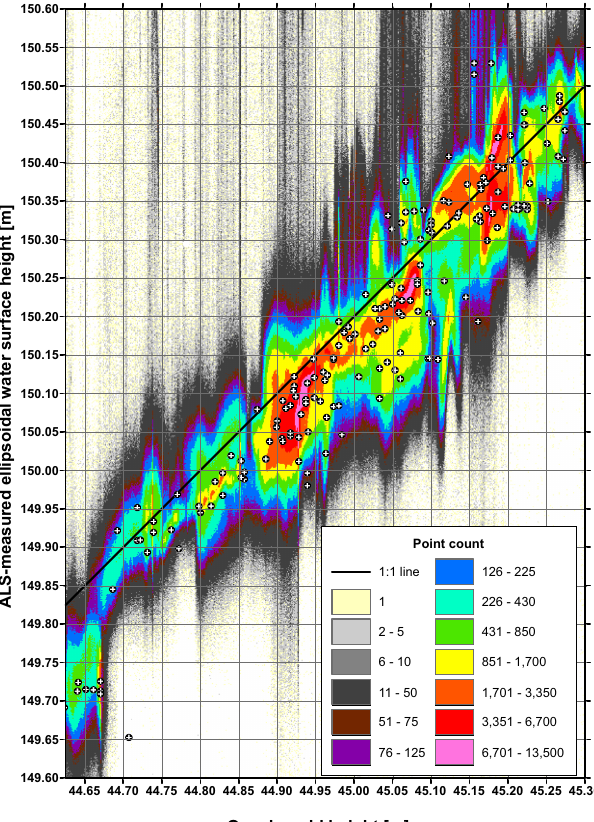
Figure 3. Scatterplot of water surface ellipsoidal heights (cor- rected with deviation of local water level from LMLL) with respect to local quasi-geoid height. Scatterplot cell coloring shows point count for each ellipsoidal water height/quasi-geoid height interval of 1.25 × 1.25cm. Bilinear interpolation of geoid undulation raster to lidar height model resolution was used for this graph. Crosses show water surface and quasi-geoid height data points resampled to quasi-geoid model resolution as used for calculating